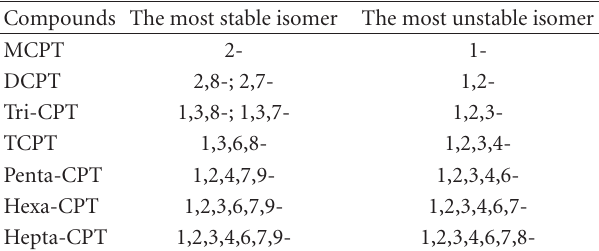
Table 4: Most stable and unstable isomers in di ff erent isomer groups for